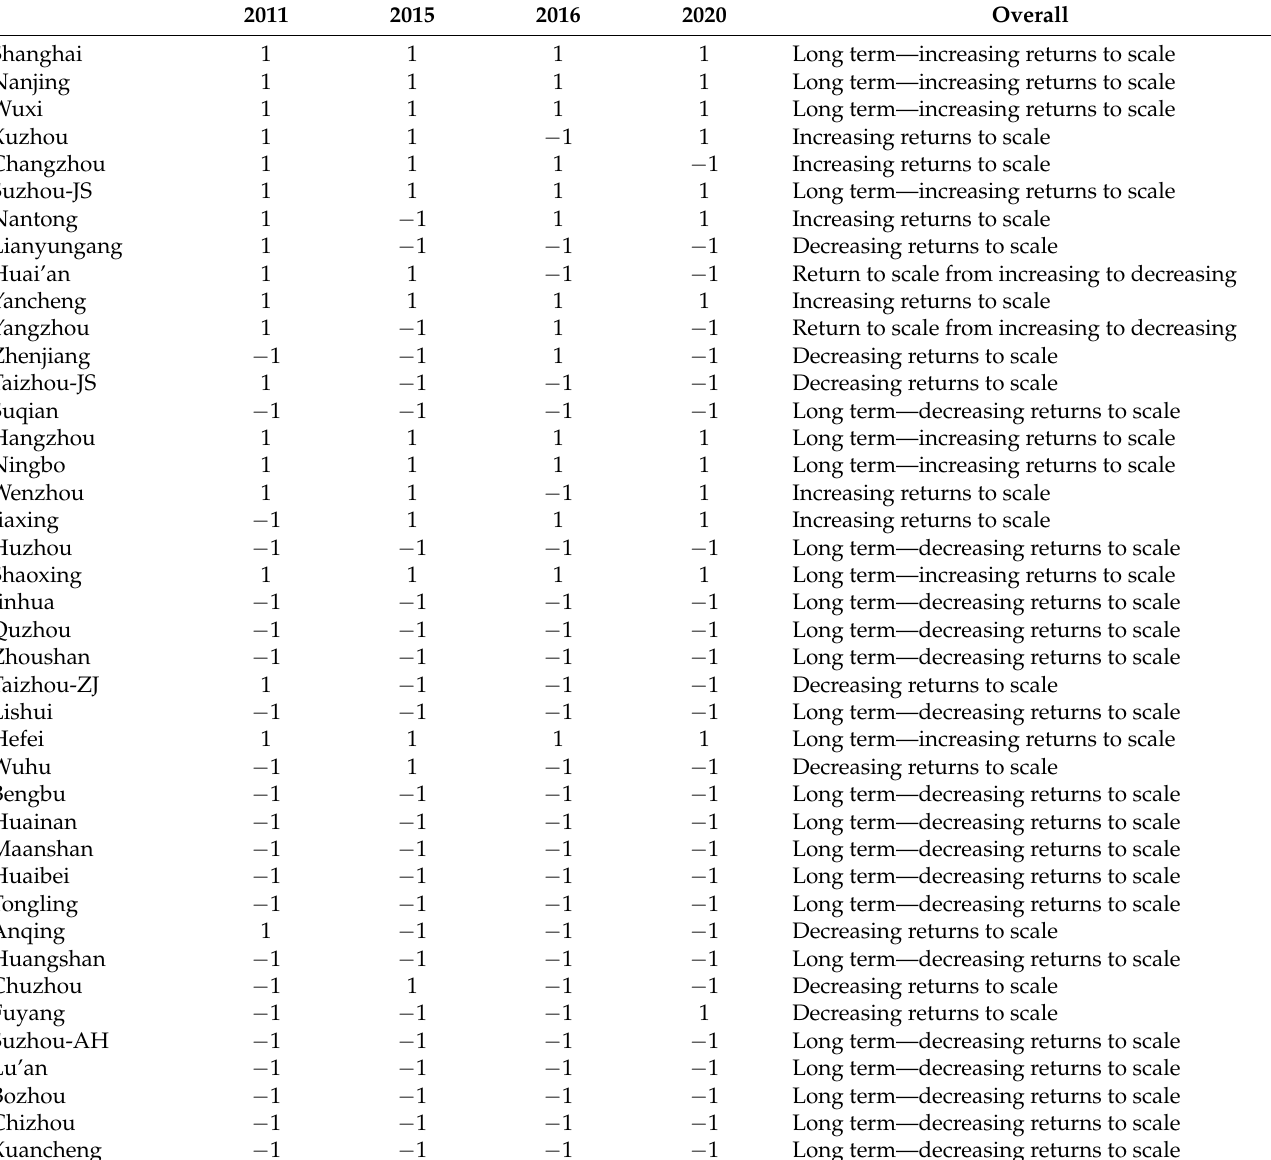
Table 5. The scale effect of real estate inventory in the Yangtze River